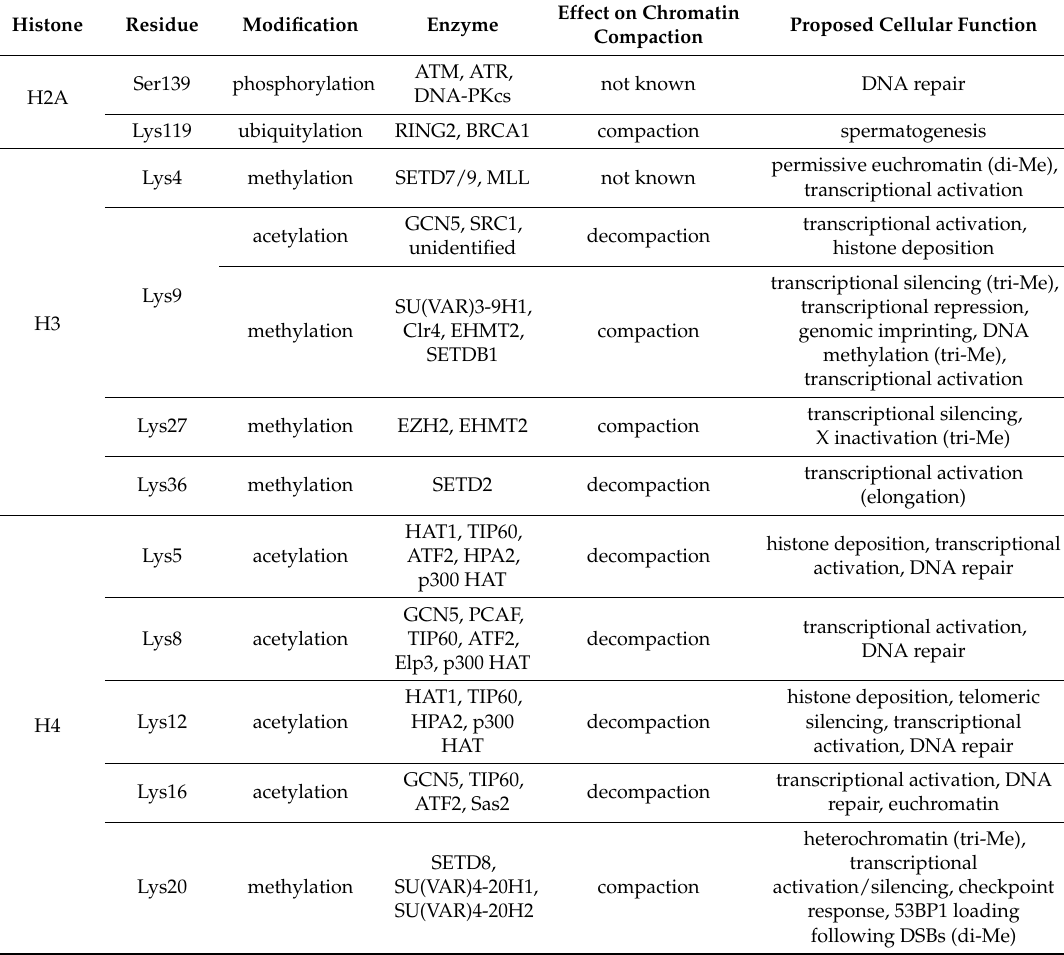
Table 1. List of histone PTMs implicated in DDR and chromatin structure